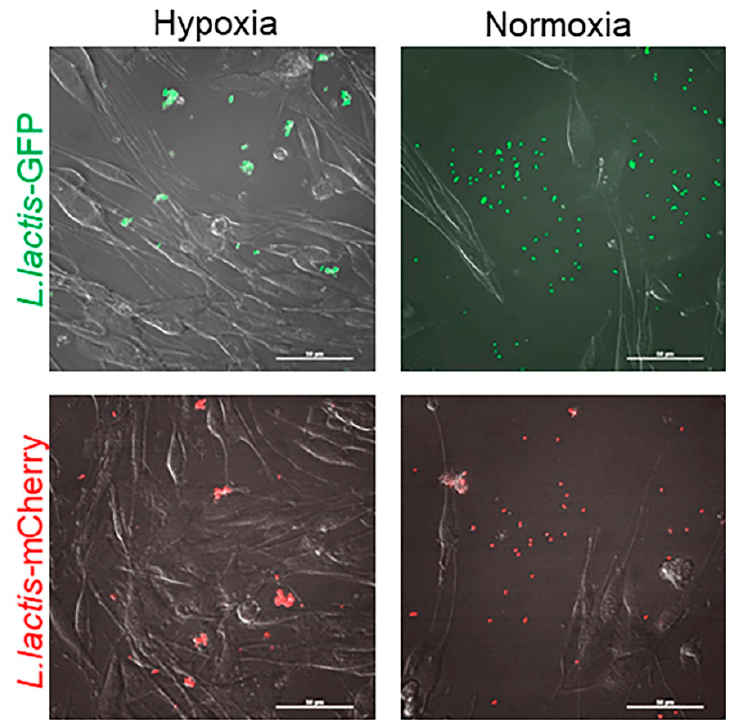
Figure 3. Induction of GFP and mCherry expression under hypoxic conditions: 3 × 10 5 MeWo cells were cultured in 35 mm glass bottom dishes. L. lactis -GFP or L. lactis -mCherry were added to the cell culture at a multiplicity of infection (MOI) of 100. Nisin (10 µg/mL) was added to the culture medium. Detection of recombinant L. lactis strains was analyzed by confocal microscopy at 24 h post-treatment. Images were taken at 100× magnification with the Nikon A1 Confocal System under 587/610 (mCherry) and 488/507 (GFP) nanometers (nm) for excitation and emission visualization, respectively. A representative experiment is shown from three performed. Scale bar = 50 µm .